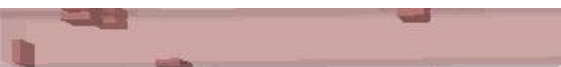
Figure 5.The corridor geometry before subspacing (only one geometry representing corridor. Top view).